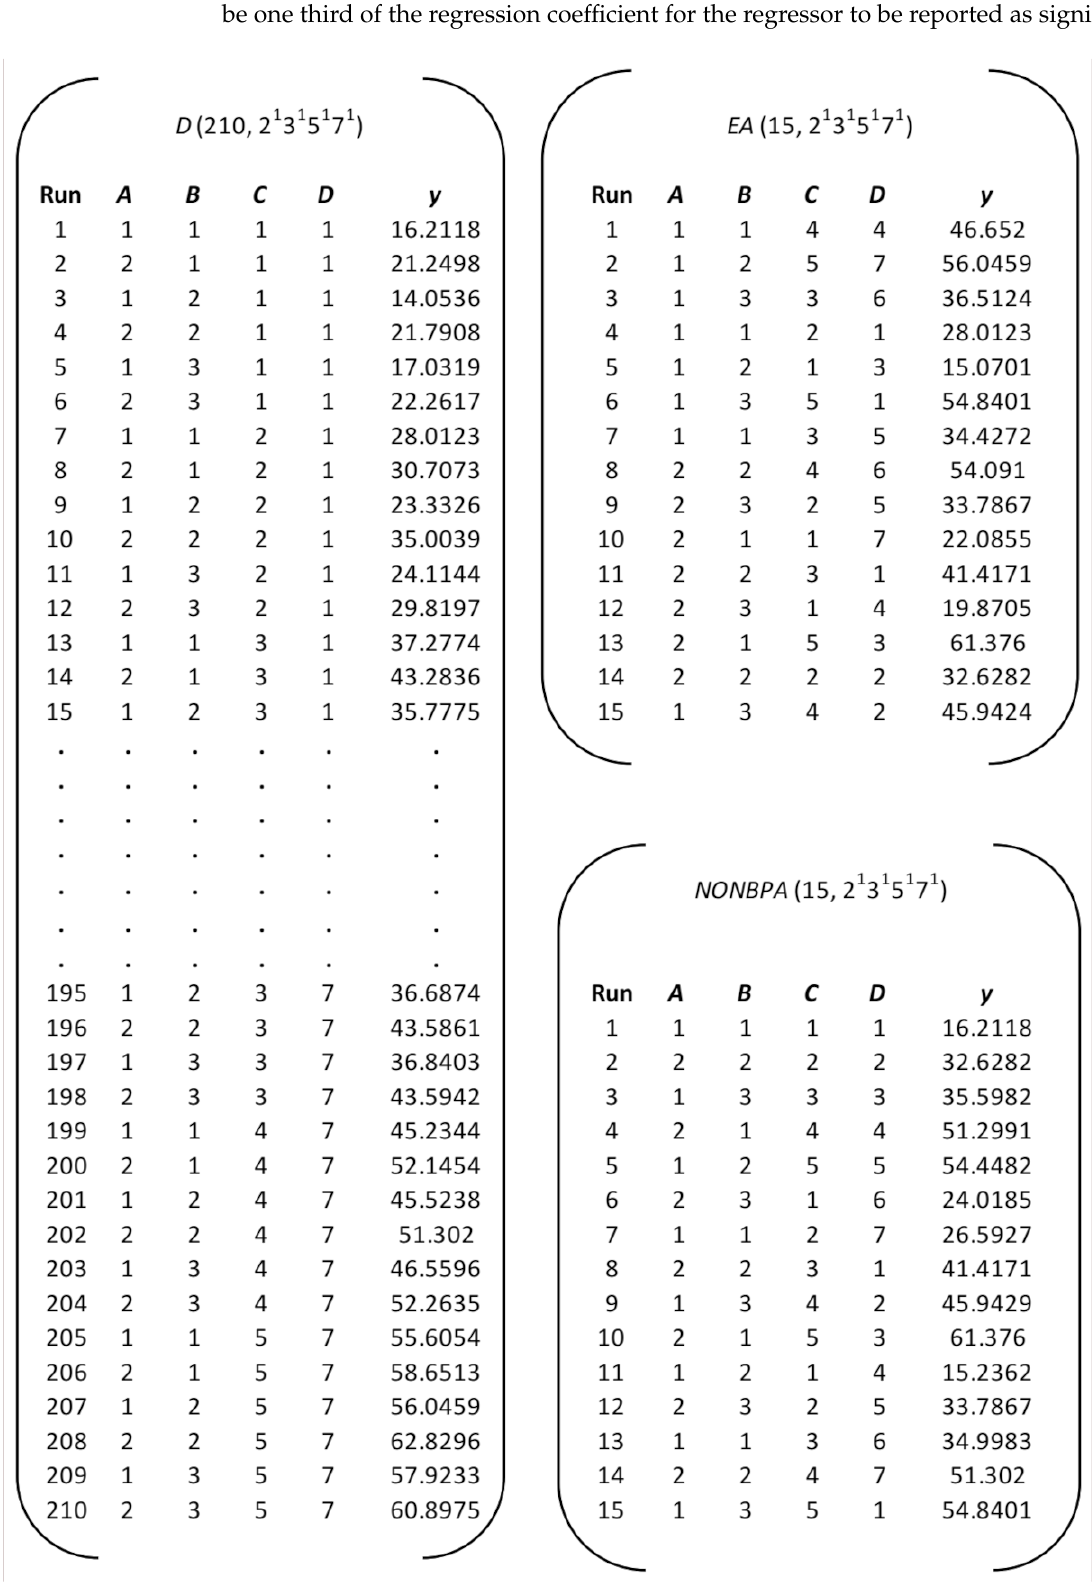
Figure 11. Simulated data for full factorial, EA and NONBPA